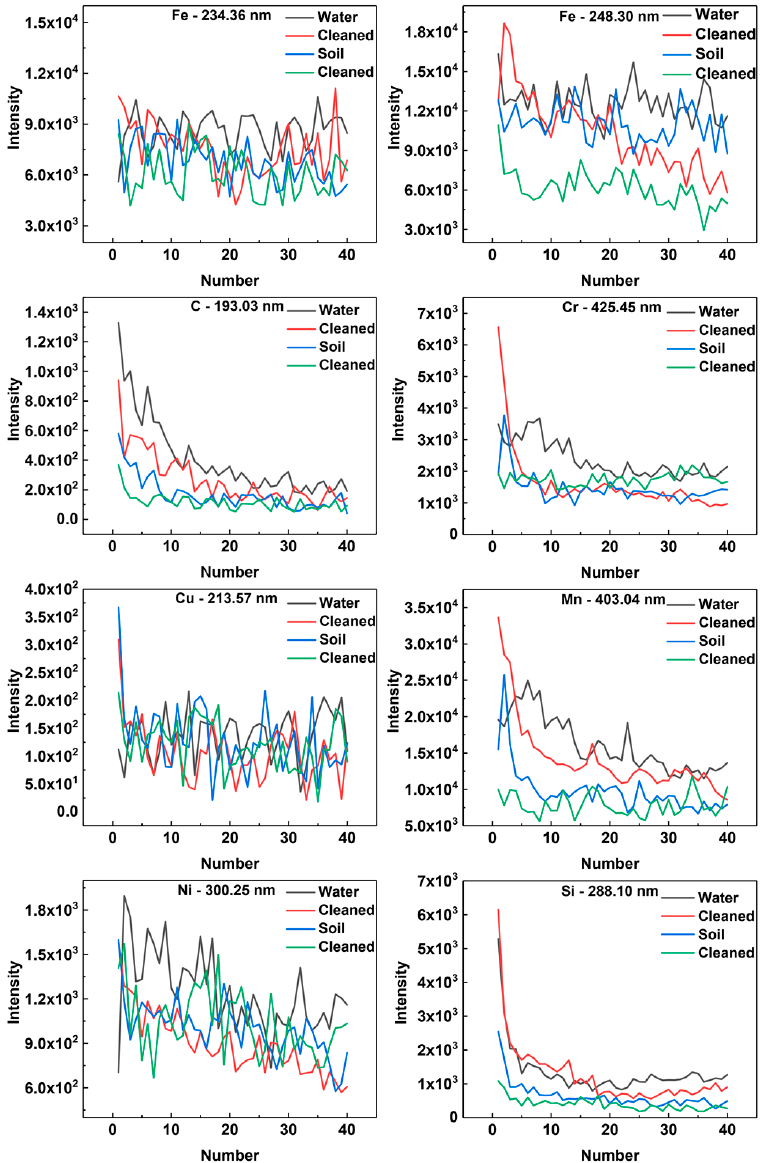
Figure 6. The signal intensity vs. the number of laser shots.